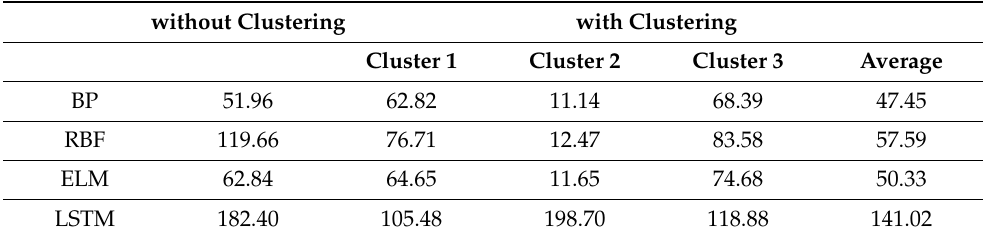
Table 3. RMSE of solar radiation forecast errors in